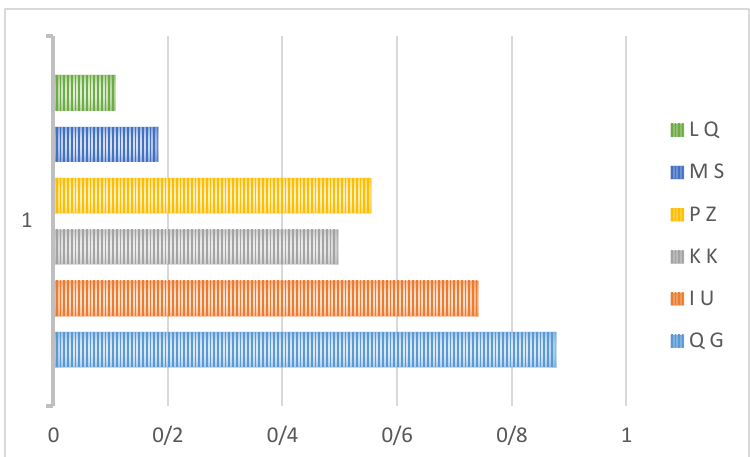
Fig. 4. Graphical representation of the final results by